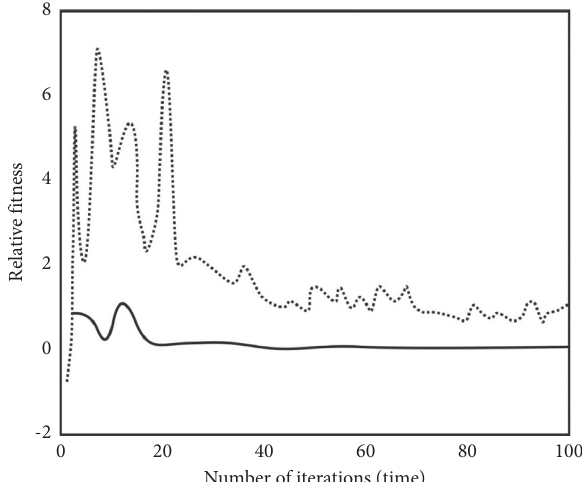
Figure 6: The iterative process of the potential field ant colony